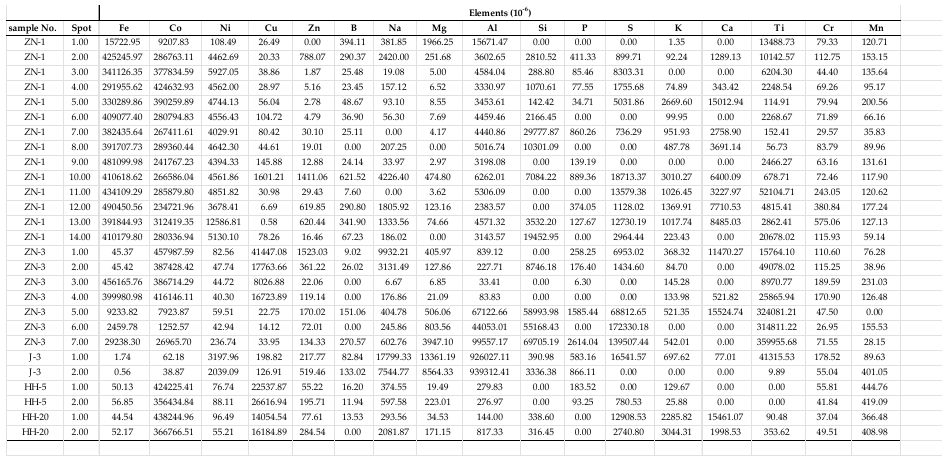
Table A1. Trace element compositions of the inclusions in HPHT diamonds.